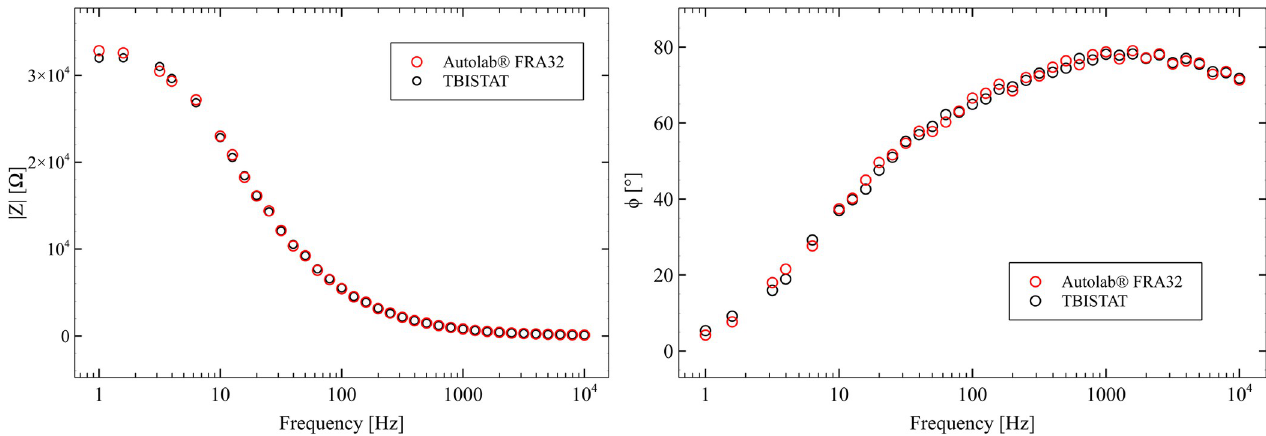
Fig 8. EIS magnitude and phase plots for TBISTAT and reference instrument in ANTI-S100B functionalized thin-film AUIDEs exposed to 316 pg/ml of S100B spiked human plasma samples.